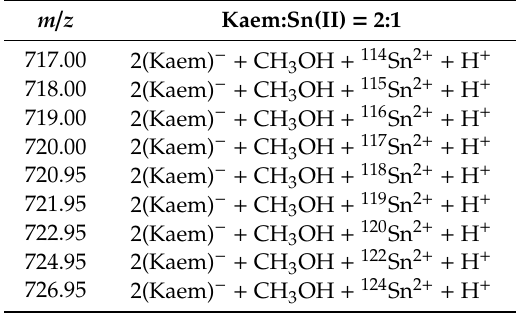
Table 1. Mass spectra ( m / z ) of 100 µ M Kaem with 50 µ M SnCl 2 in methanol.